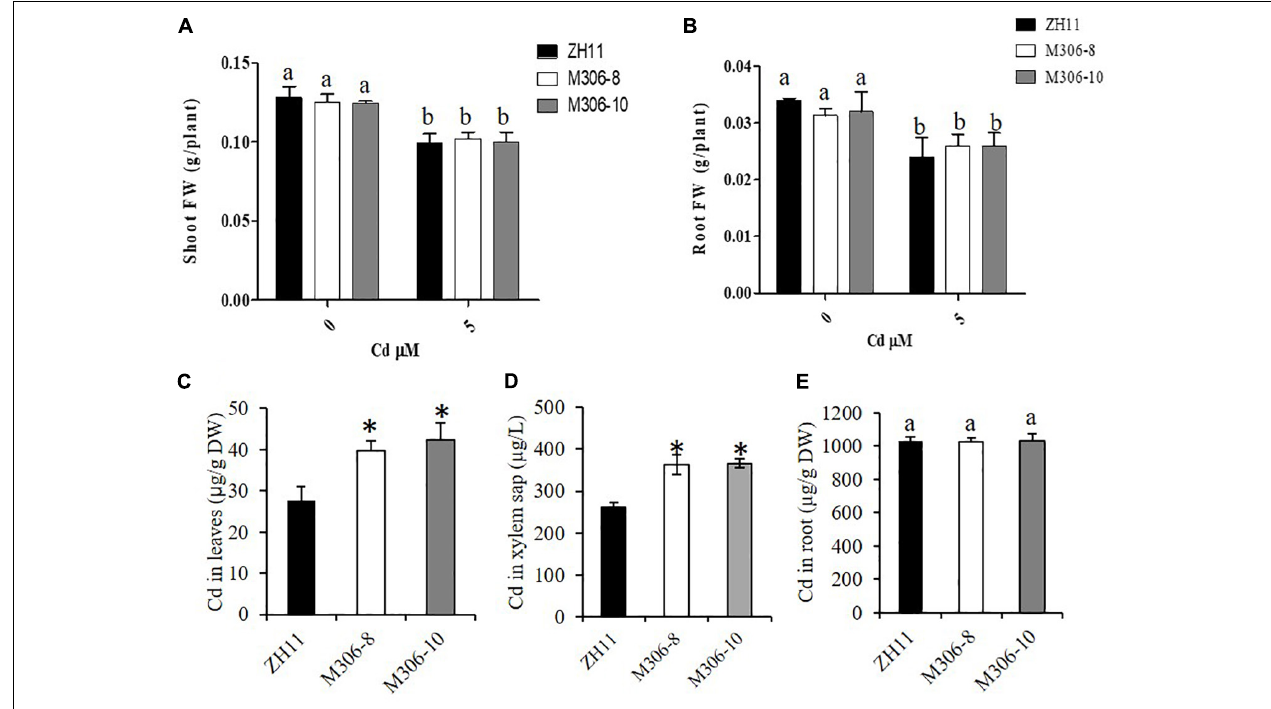
FIGURE 7 | Cd tolerance assays of CAL2 overexpression lines. Transgene-negative control ZH11 and 35S:CAL2-mRFP transgenic rice seedlings were grown for 14 days in hydroponics supplemented with 0 or 5 µ M Cd, and then sampled to determine fresh weights (FW) of shoot (A) and roots (B) , Cd concentration in leaves (C) , xylem sap (D) and roots (E) were determined by ICP-MS. Data are mean ± SDs of three independent biological replicates. Bars with the same letters are not significantly different at P < 0.05 using the LSD method. Significant differences from ZH11 were determined by Student’s t test ( ∗ P <